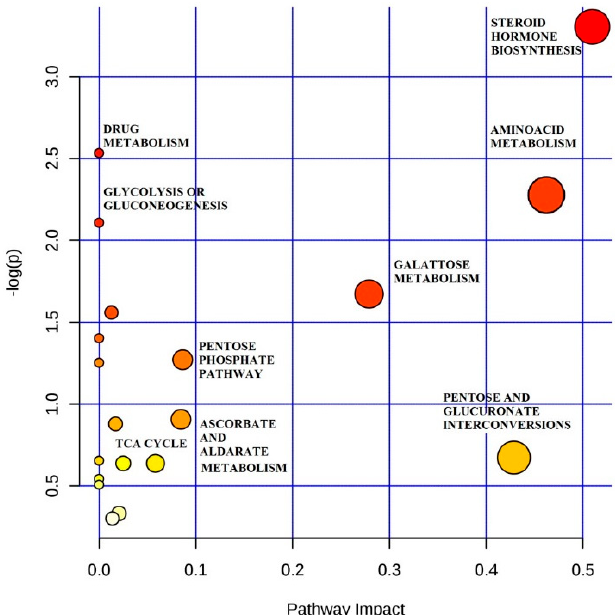
Figure 2. Metabolic Pathway Analysis (MetPA). All the matched pathways are displayed as circles. The color and size of each circle are based on the p -value and pathway impact value, respectively. The graph was obtained by plotting on the y -axis the − log of p -values from the pathway enrichment analysis and on the x -axis the pathway impact values derived from the pathway topology analysis. Table 1. Estrogen amount extracted from the urine in the two stages of pregnancy (OL and IL-DP). The table refers to the relative concentration of the metabolites calculating as a percentage of the total hormones by comparing the intensity of deconvolution of each hormone. Estrogens Molecular Weight Detection Mode Out of Labor Active Phase Retention